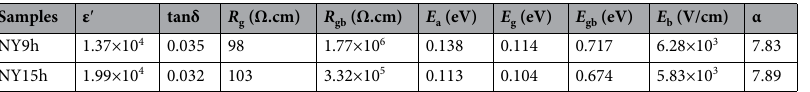
Table 3. ε ′ and tanδ at 1 kHz and 20 °C, R g at 20 °C, R gb at 60 °C, activation energy of relaxation ( E a ), and activation energies of grains ( E